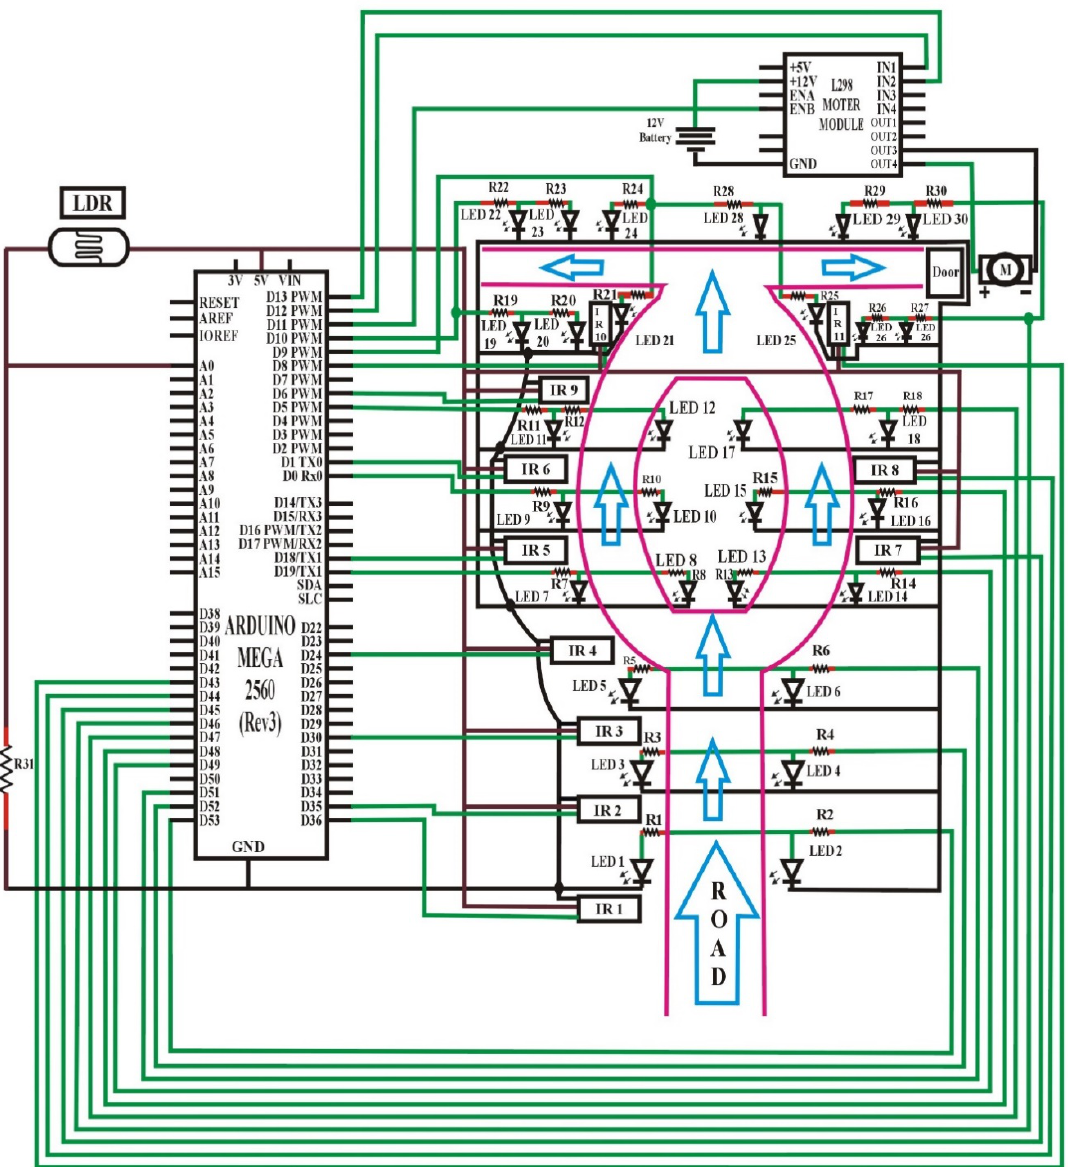
Figure 5. Circuit design of the automation system based on object detection and an automatic door system.